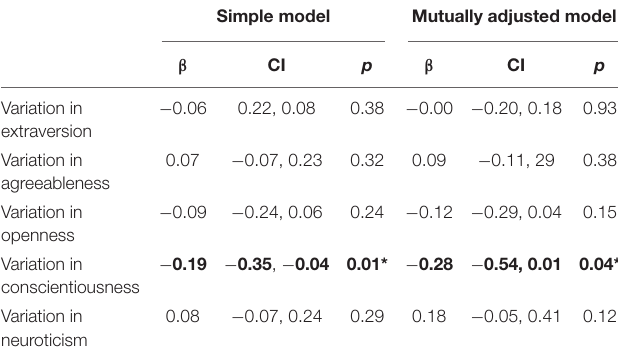
TABLE 3 | Group performance and personality variation, N =